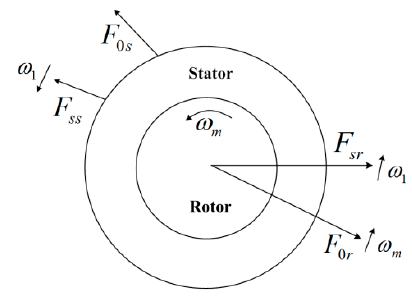
Figure 4. Schematic diagram of asynchronous motor magnetic potential.